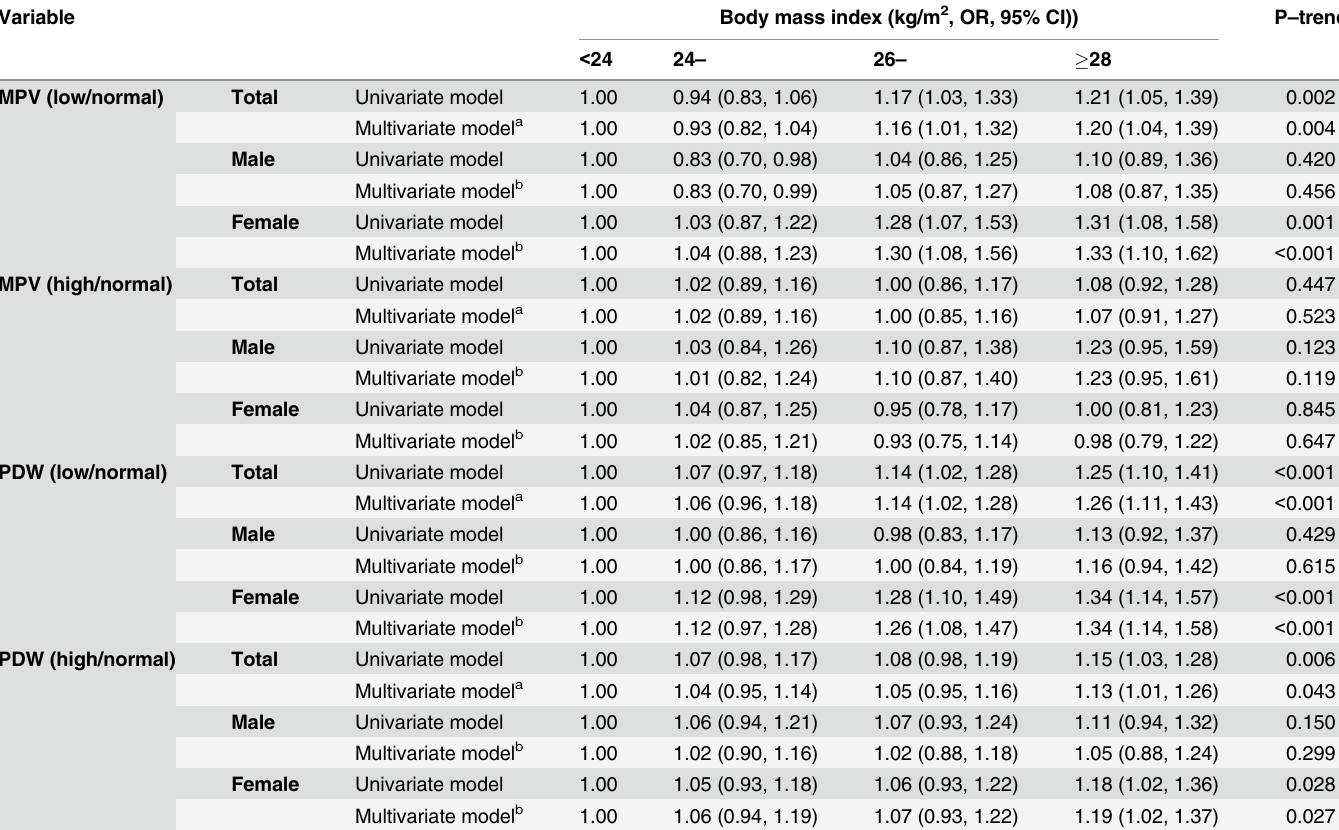
Table 5. Association between body index mass and platelet indices among 17327 participants.